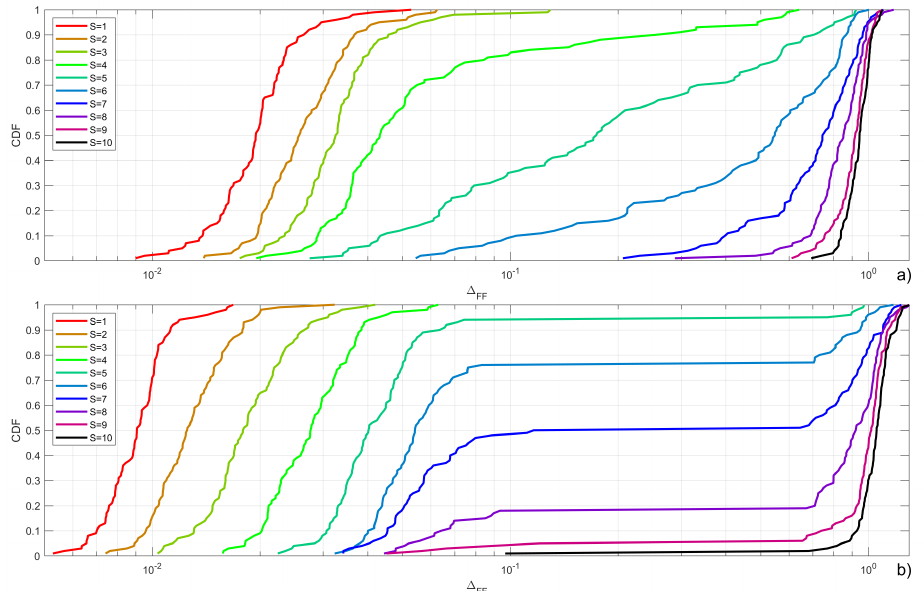
Figure 8. Cumulative density function of the reconstruction error for a variable number of sparse sources in the Ξ region for SNR = 40dB. Subplot ( a ): “standard” approach; subplot ( b ): “smooth”